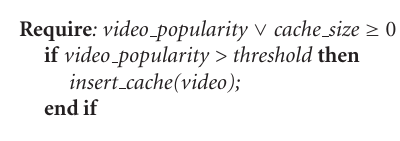
Algorithm 2: Considering video